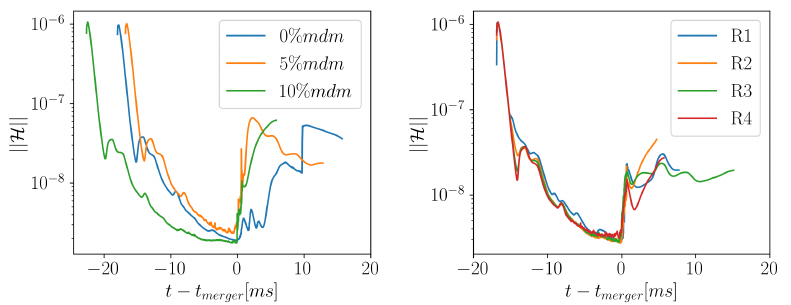
Figure A1. Left : Evolution of Hamiltonian norm for 1.3 M (cid:12) simulation on the coarsest level. Overall, we find a decreasing constraint violation before the merger, due to the constraint damping properties of the Z4c evolution scheme. The jumps at late times are due to the merger and then the formation of a singularity. Right : Hamiltonian norm on the coarsest level for the simulation of a 1.4 M (cid:12) and 5% mirror dark matter star for the four different resolutions described in Table